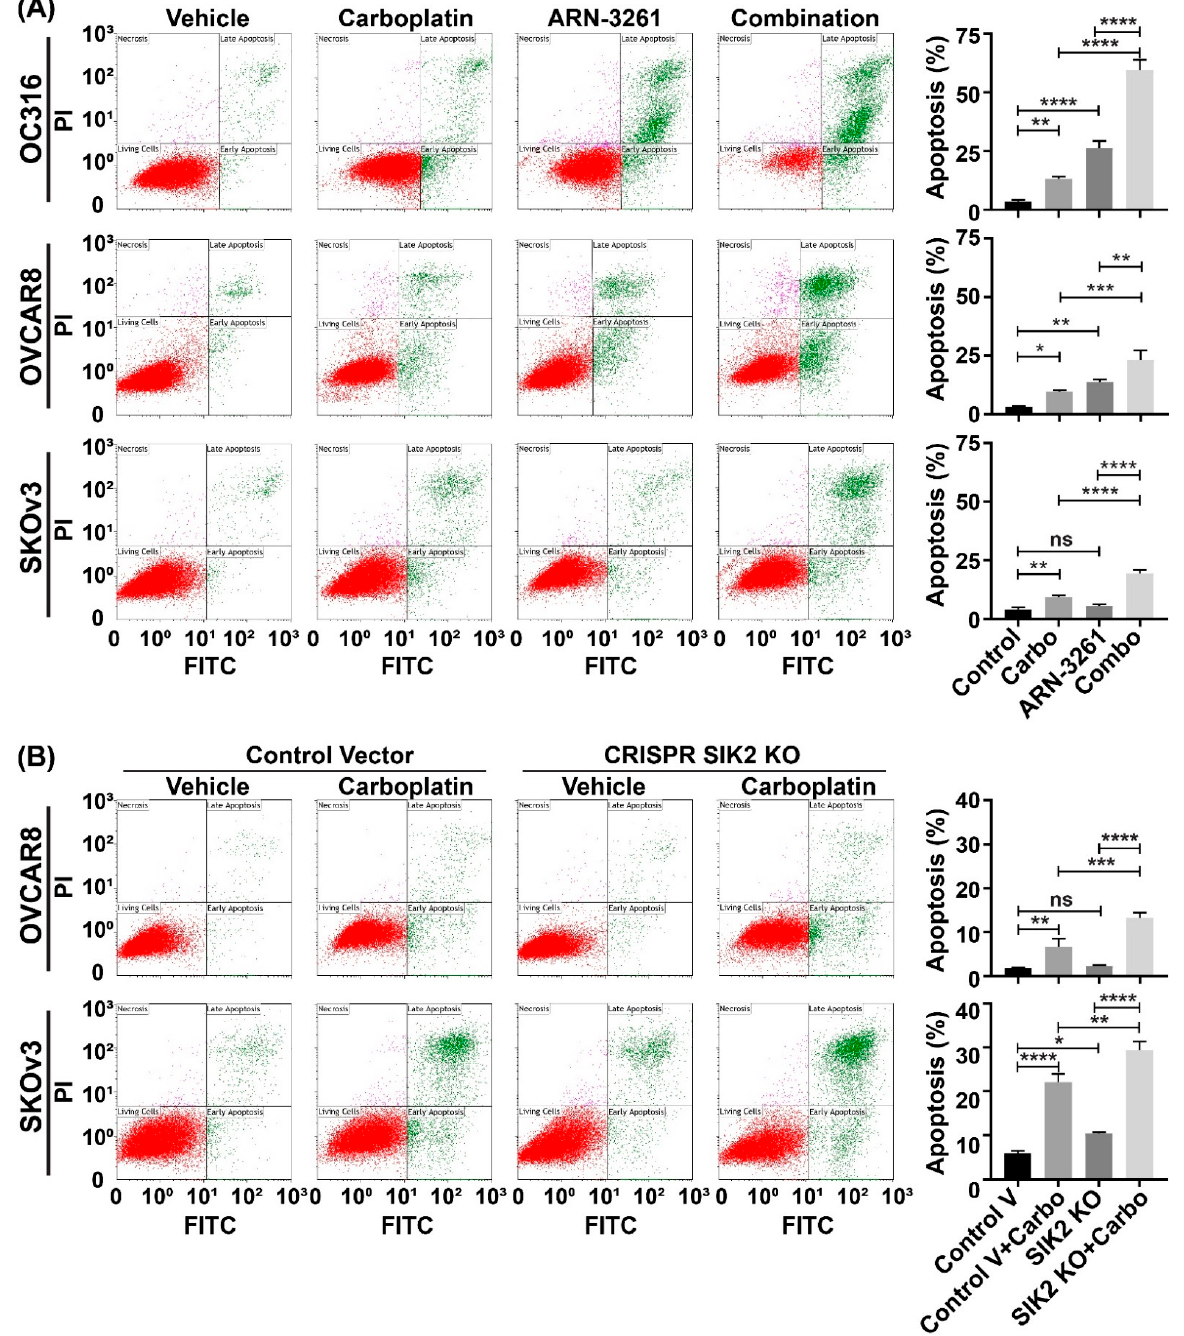
Figure 2. Inhibition of SIK2 activity with ARN-3261 or knockout of SIK2 protein enhances carboplatin-induced apoptosis. ( A ) Effect of ARN-3261 on carboplatin-induced apoptosis. OC316, OVCAR8 and SKOv3 cell lines were plated at a density of 8000 cells/well in 12-well plate in triplicate, and then treated with ARN-3261 (OC316 3 µM, OVCAR8 5 µM and SKOv3 4.5 µM) and/or carboplatin (OC316 15 µM, OVCAR8 70 µM and SKOv3 60 µM) for 72 h. Cells were dislodged and stained with Annexin V antibody and PI dye for flow cytometry. Representative images are shown on the left and the analysis of apoptotic population under different treatment conditions are on the right. ( B ) Effect of SIK2 knockout on carboplatin-induced apoptosis. SIK2 knockout (KO) and control cell lines were treated as in ( A ) and analyzed for apoptosis. The bars indicate the mean percentage of apoptotic cells with standard deviations. Statistical significance is indicated by * p < 0.05, ** p < 0.01, *** p < 0.001 and **** p < 0.0001. ns: not significant by one-way ANOVA